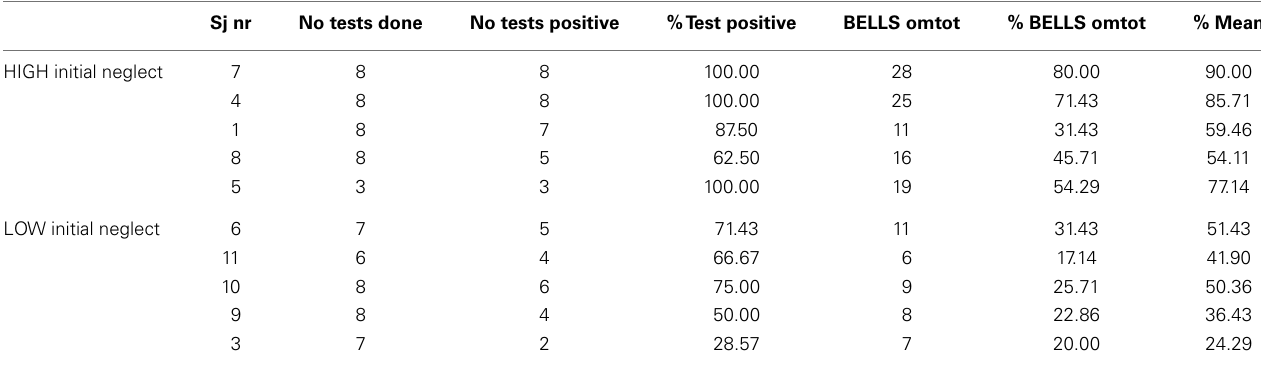
Table 4 | Initial neglect severity in the baseline test